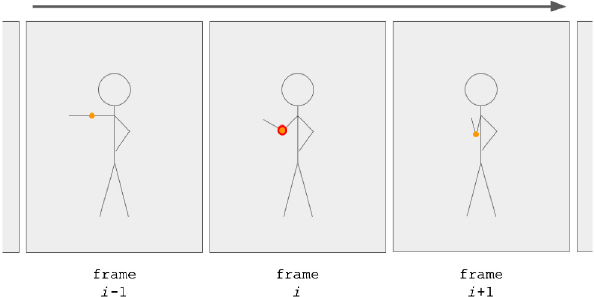
Fig. 3 Temporal consistency calculation (see Eq. (7)) for frame i , for the elbow joint (orange) and the temporal mean position of the joint